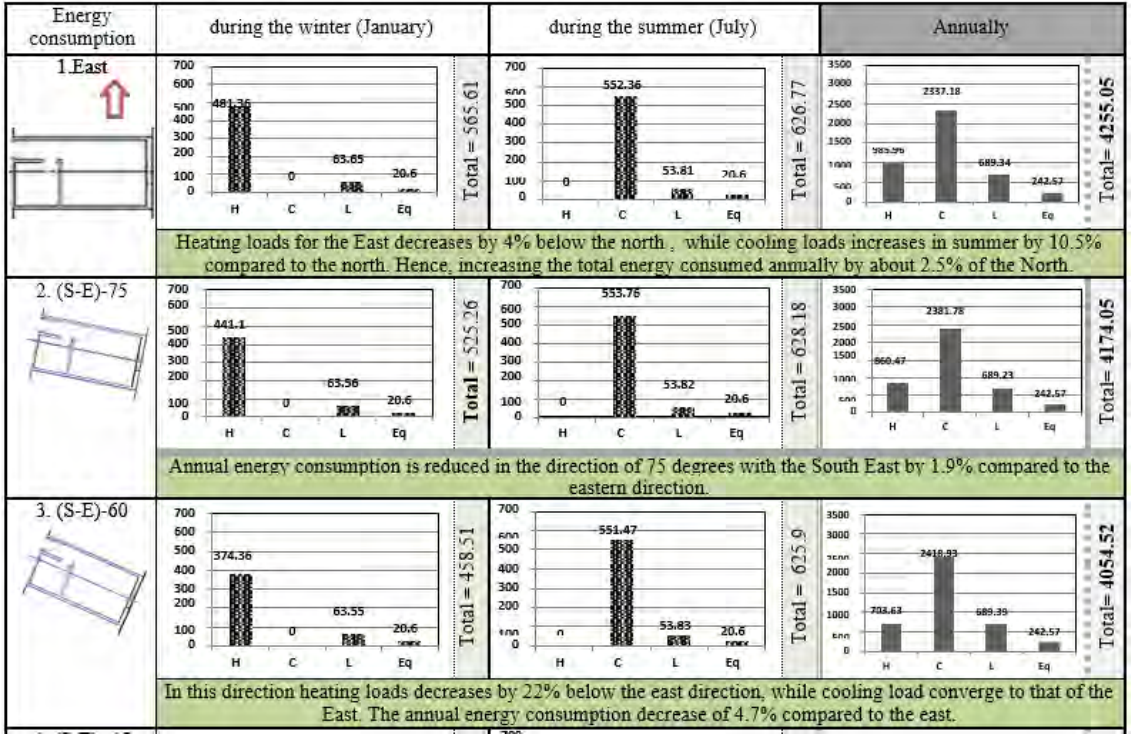
Table 4: Analysis of energy consumption in the directions (east + southeast) annually and during the summer and winter